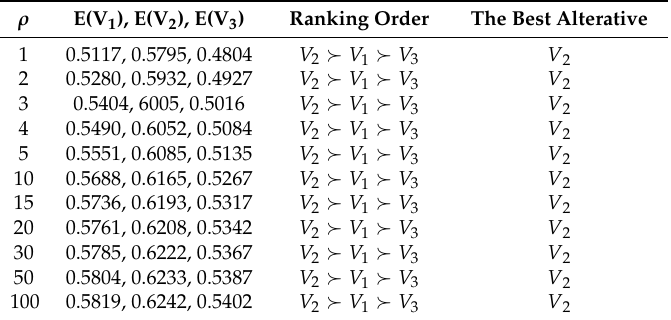
Table 3. Ranking orders of the LCVDWAA operator, ρ ∈ [1–5,10,15,20,30,50,100].